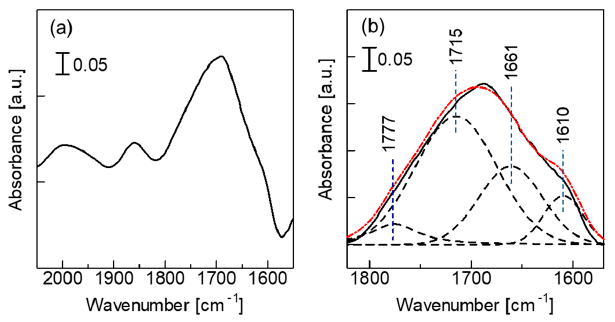
Figure 6. ( a ) In-situ Fourier transform infrared (FTIR) spectra for In-CHA(Al-rich) measured at 153 K after H 2 treatment at 773 K. ( b ) Deconvolution of the band around 1700 cm − 1